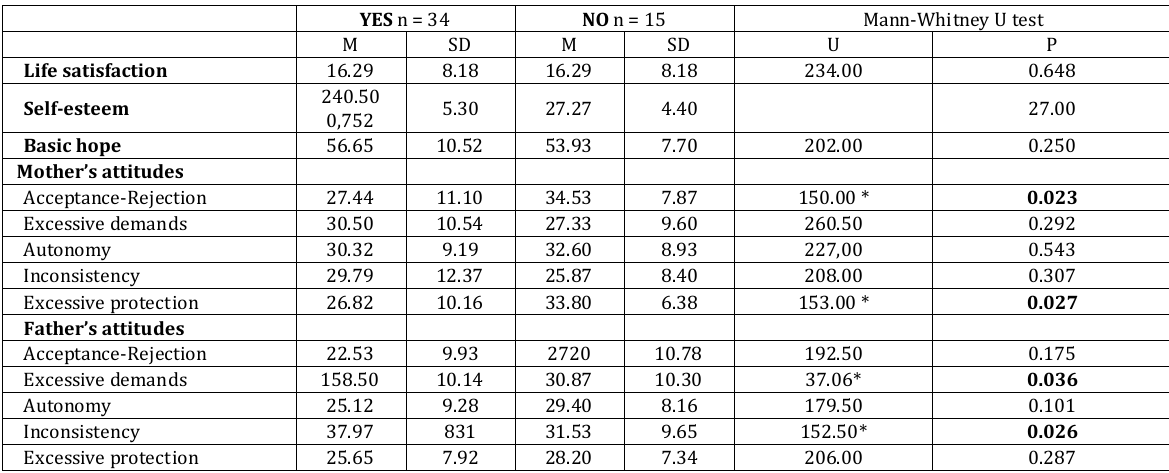
Table 2. Comparison of life satisfaction, self-esteem, basic hope and retrospective assessment of parental attitudes with regard to the occurrence of domestic